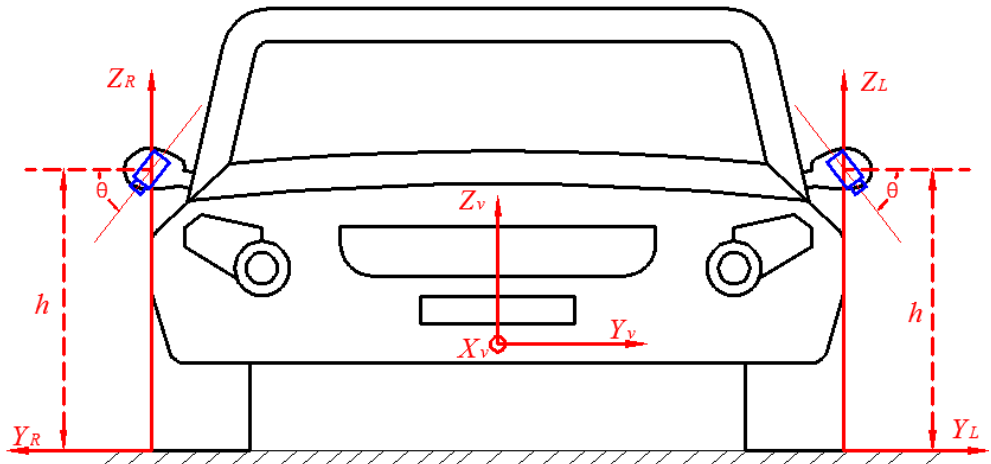
Figure 5. Extrinsic configuration of the side cameras and associated coordinate systems.